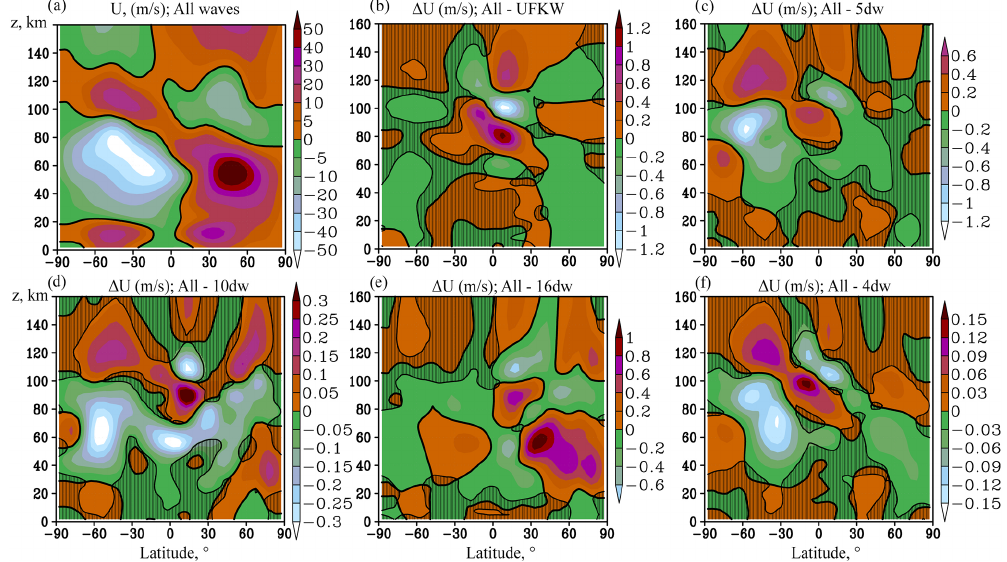
Figure 3. (a) Zonal wind components (colours, (ms − 1 ) for January–February with all PW sources turned on; (b–f) increments in zonal wind due to switching off sources of PWs: UFKW, 5, 10, 16 and 4d waves. Shaded areas show insignificant wind increments at